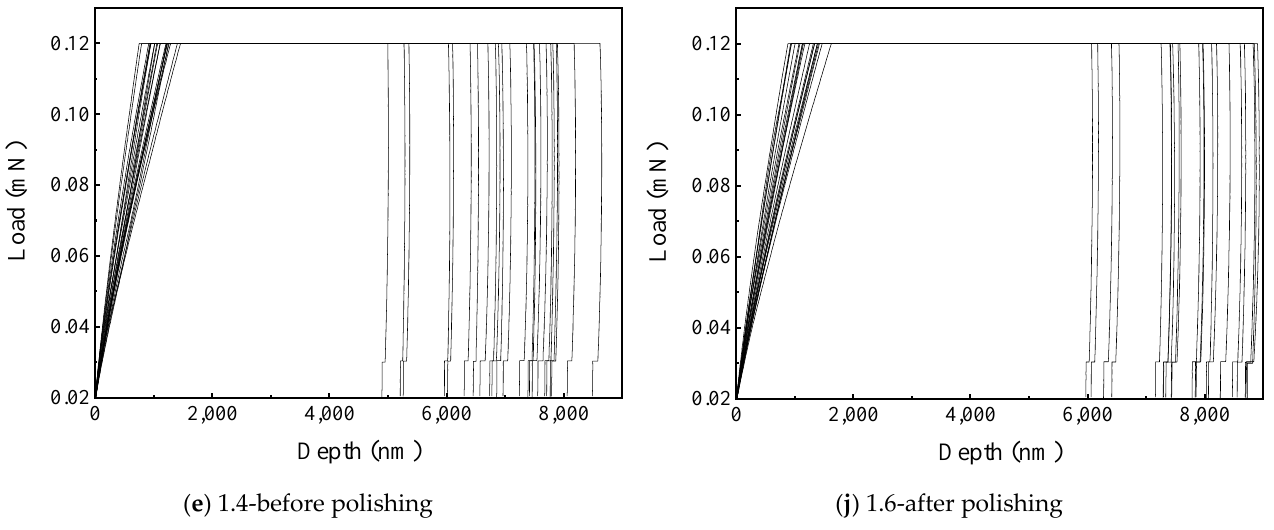
Figure 11. Different rates of filler and asphalt load depth curves before and after polishing. The red scale in the lower right corner of Figure 9a,b is 10 µ m, while the white area is the asphalt phase. It can be presumed that the black particles are mineral powder particles with particle sizes below 0.075 mm. By comparing Figure 9a,b, it can be